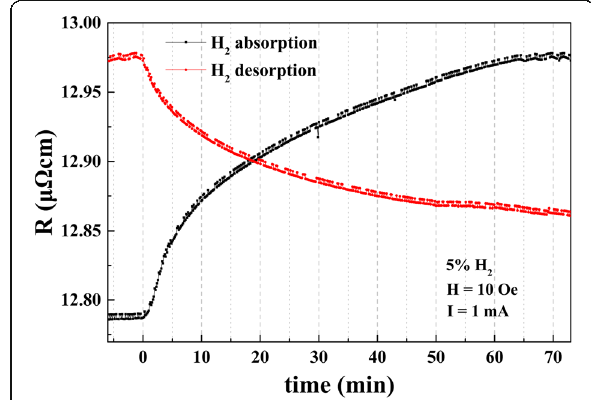
Fig. 5 The dependence of the Hall resistivity on time under H 2 absorption and desorption for Ta/Pd/CFMS (2.3 nm)/MgO (1.3 nm)/ Pd films annealed at 300